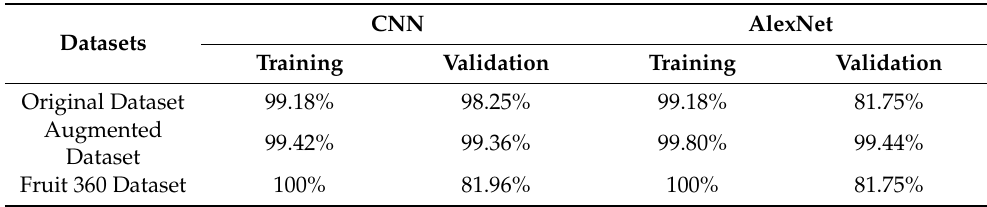
Table 4. Training and validation accuracy for CNN and AlexNet model.